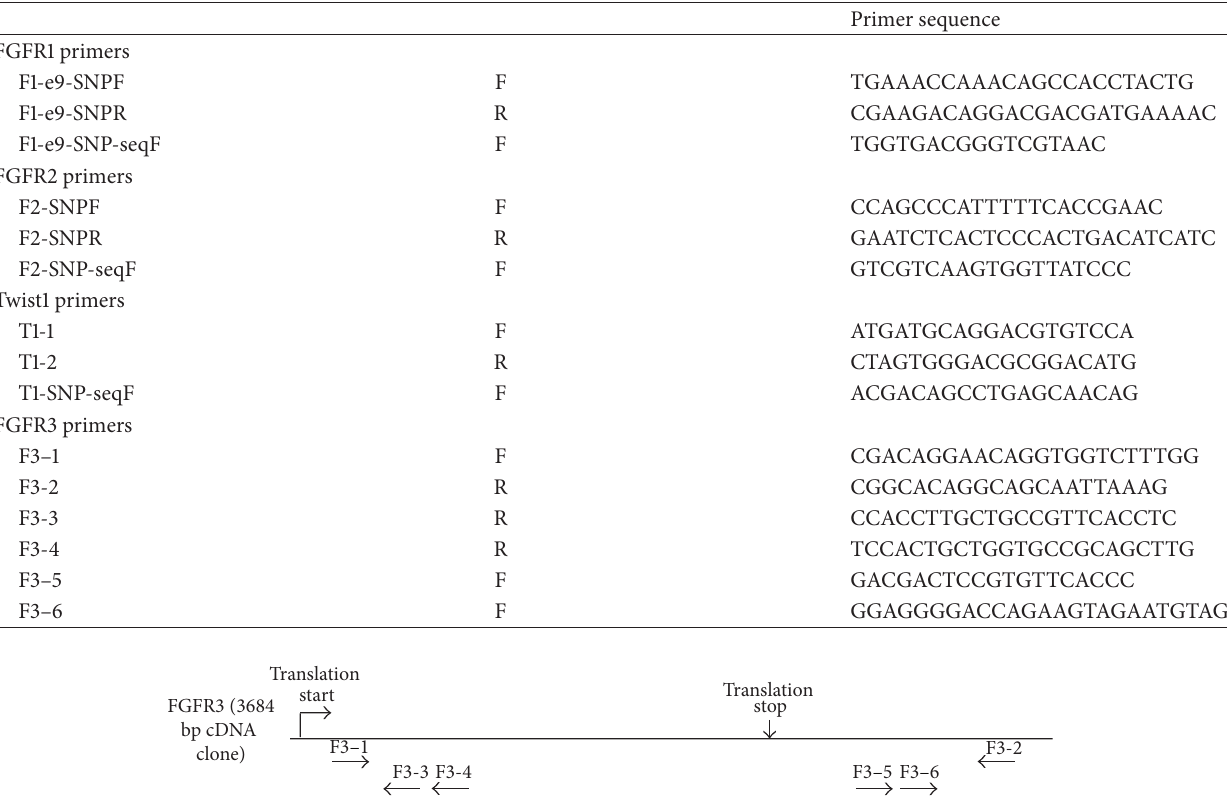
Table 1: Primers used in this study.